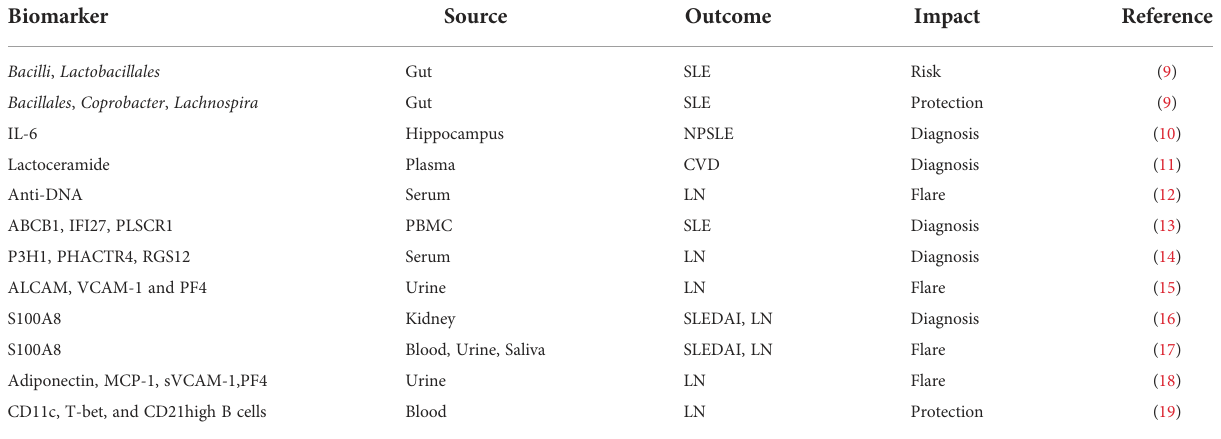
TABLE 1 New biomarkers for the diagnosis and treatment of